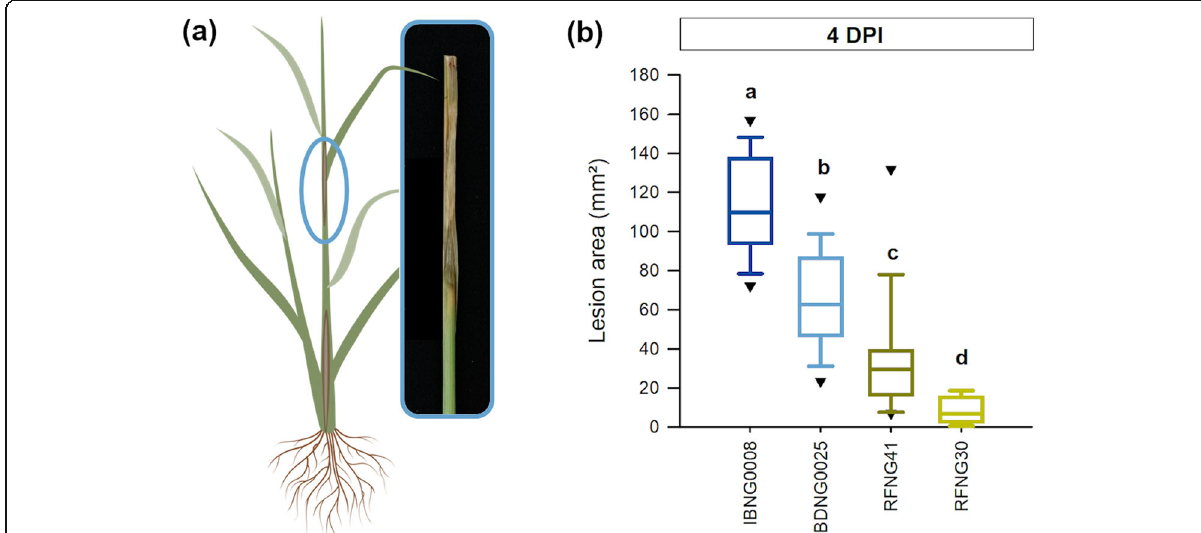
Fig. 1 Virulence of Sarocladium oryzae on Kitaake rice plants. When 7 weeks old, rice plants were inoculated in the axil of the second youngest leaf by use of the standard grain inoculum technique ( a ). Disease was evaluated at 4 days post inoculation (DPI) with S. oryzae isolates IBNG0008 (dark blue), BDNG0025 (light blue), RFNG41 (dark green) and RFNG30 (light green) ( b ). All boxplots show the median with the first and third quartile, the whiskers show the minimum and maximum values. Outliers and extreme values are represented by triangles. Boxplots marked with different letters are statistically different (ANOVA, n = 20, α =